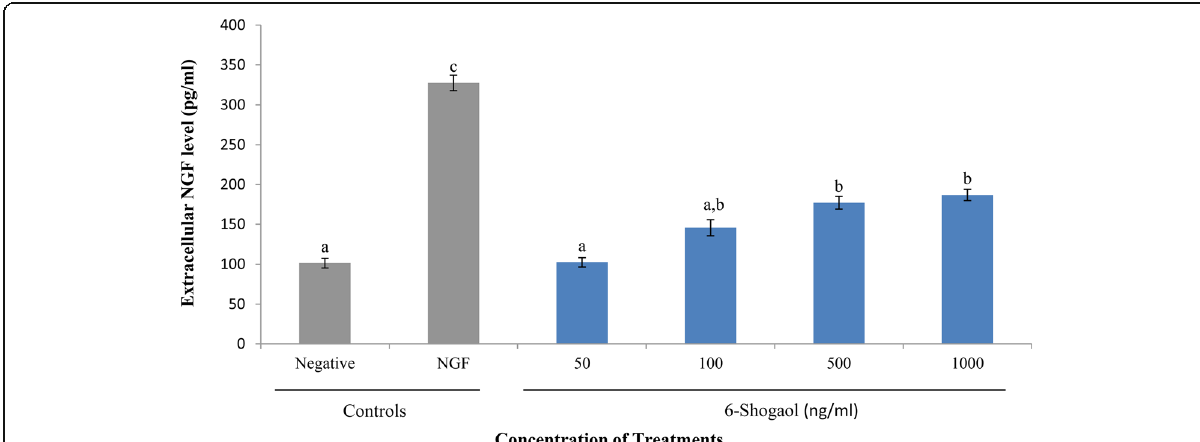
Fig. 5 Extracellular NGF concentration in supernatants of NGF- and 6-shogaol-treated PC-12 cells. Cells were incubated with NGF (50 ng/ml) or 6-shogaol for 48 h. Cells in complete F-12 K medium served as a negative control. The concentration of extracellular NGF (pg/ml) was interpolated from the NGF standard curve using the average absorbance value of triplicate wells. Data were expressed as means ± SD from three